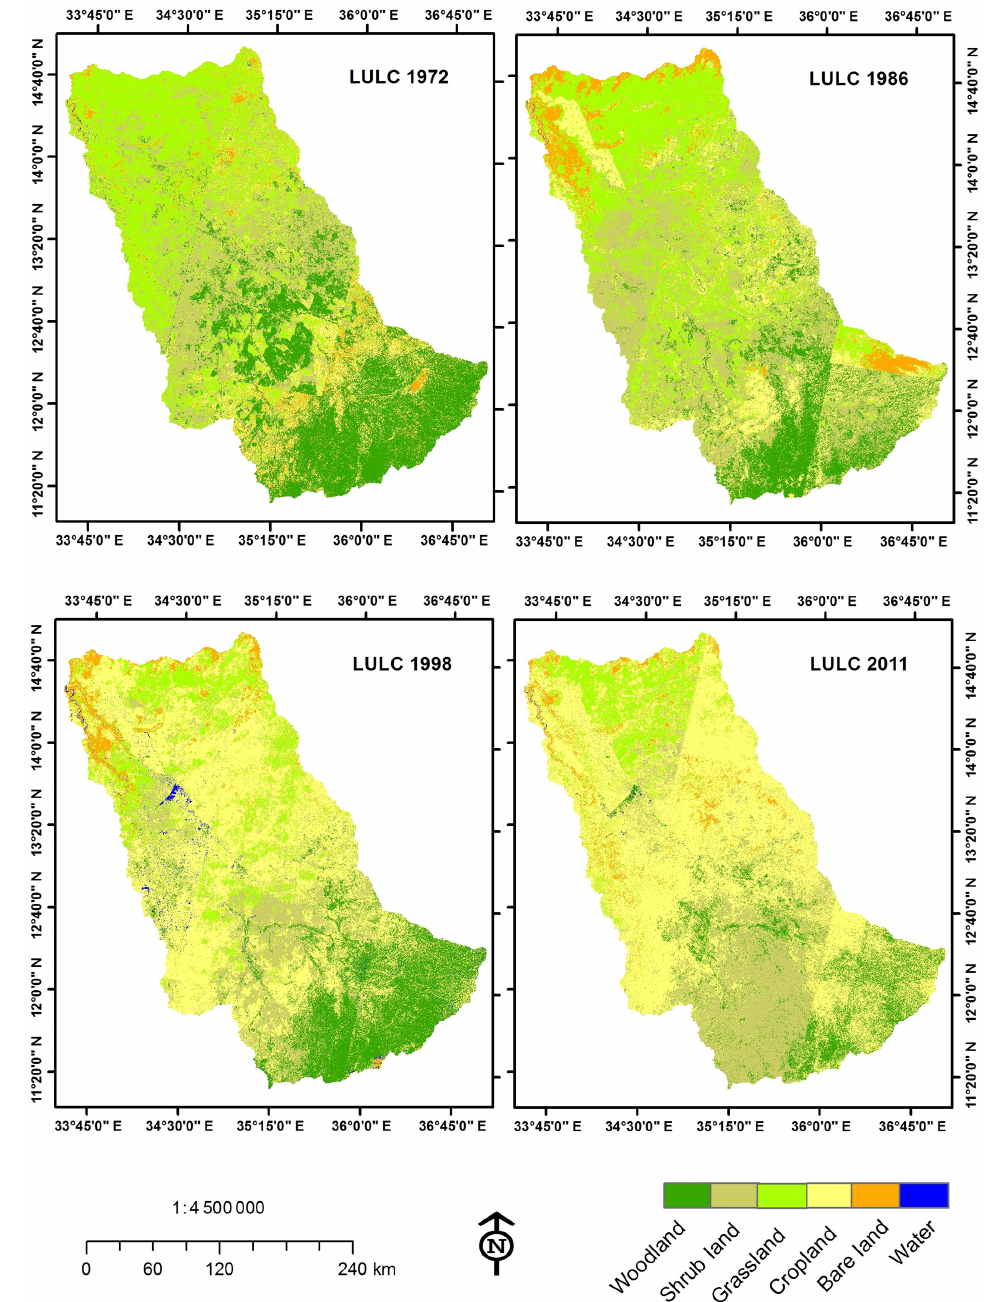
Figure 3. Classified LULC maps of the years 1972, 1986, 1998 and 2011.